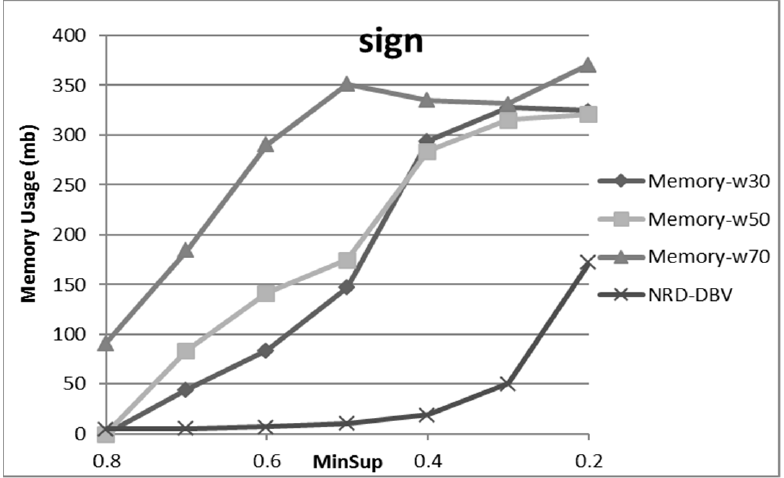
Figure 9. Comparison of memory usage for the TRuleGrowth with the NRD-DBV algorithm for (Sign) dataset.